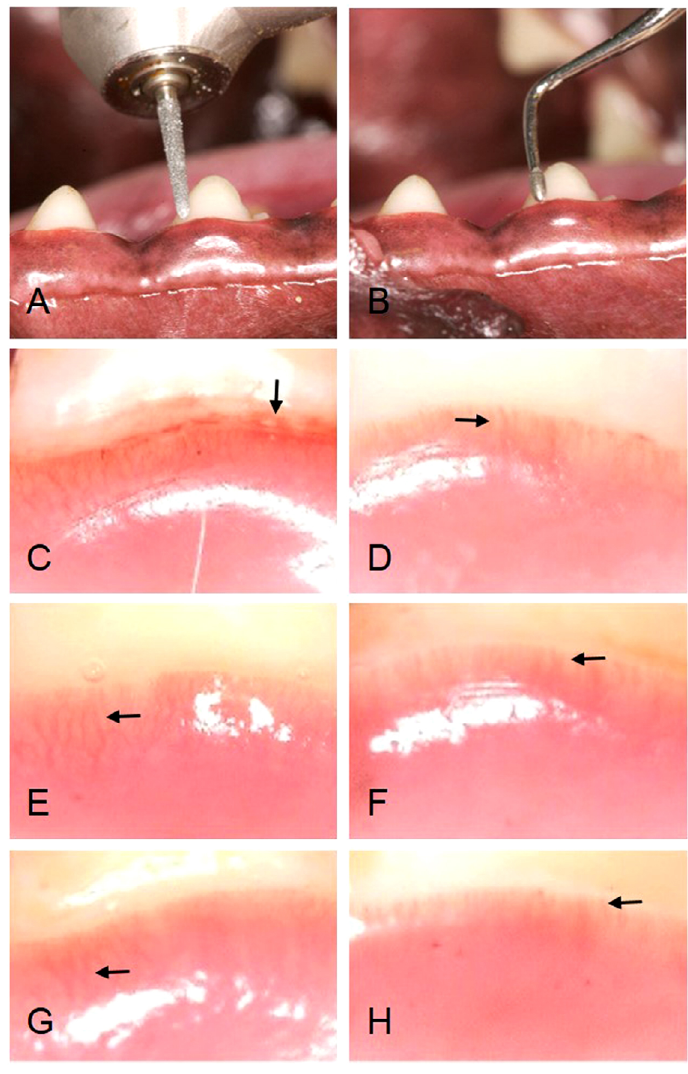
Figure 1- An oral view of the gingival blood vessels in the turbine group and ultrasonic group. A: The diamond bur and dental air turbine. The dentition on the one mandible was prepared by a diamond bur and dental turbine with water spray. B: An ultrasonic device using a diamond tip. The dentition on the mandible was prepared by ultrasonic waves using a diamond tip with water. C: On Day 0, in the turbine group, blood vessels are extended with bleeding (arrows). D: On Day 0, in the ultrasonic group, a vascular loop (arrows) was continuously formed along the finishing line. E: On Day 7, in the turbine group, blood vessels are extended (arrows). F: On Day 7, in the ultrasonic group, a vascular loop (arrows) was formed along the finishing line. G: On Day 30, in the turbine group, an extended vascular loop (arrows) is visible in the marginal gingiva. H: On Day 30, in the ultrasonic group, a vascular loop (arrows) was formed in the marginal